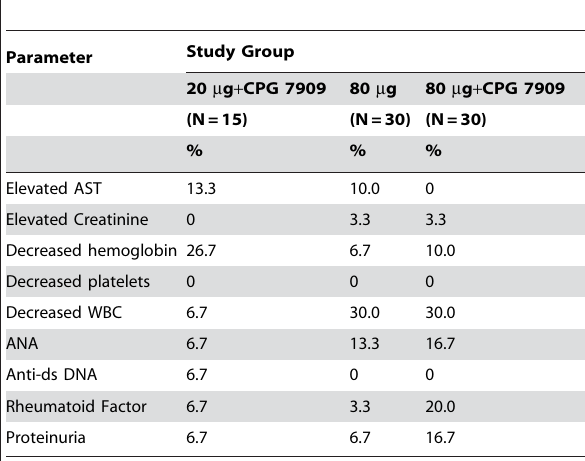
Table 2. Percentage of Subjects with Abnormal Laboratory